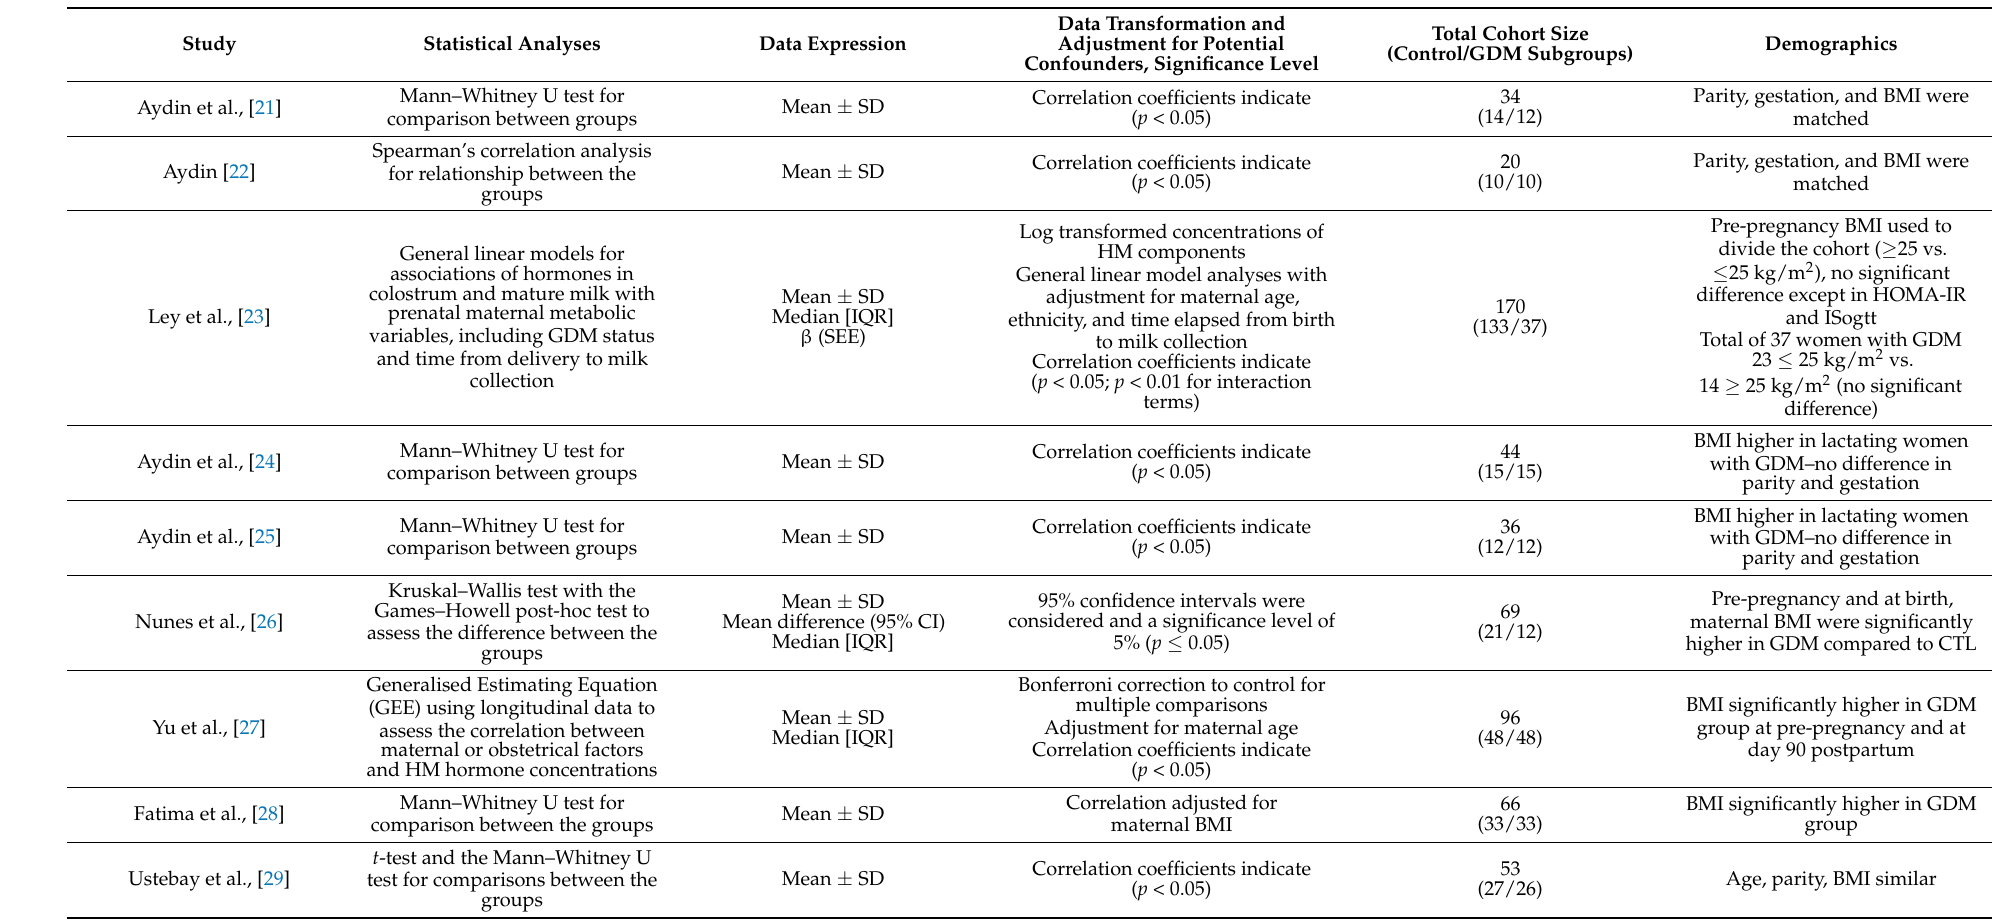
Table 2. Statistical analyses of relationships between maternal gestational diabetes mellitus and HM metabolic